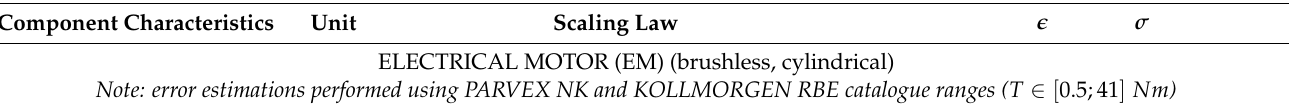
Table 3. Electrical motor scaling law sum up and prediction quality compared to manufacturer catalog